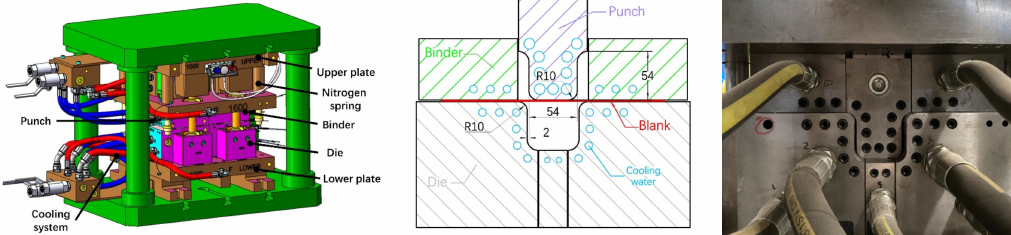
Figure 18. TPP system.